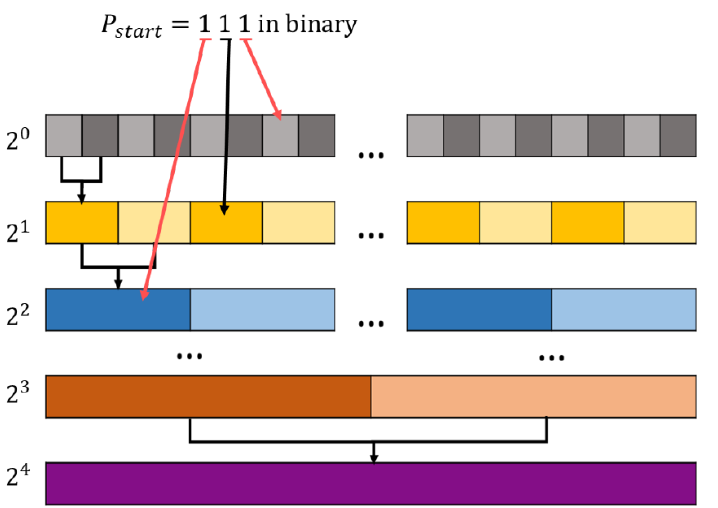
Figure 2. A diagram of the sum from the first point to the P start -th (=7) point of the sequence in binary, which is employed for A-RSE-f1.